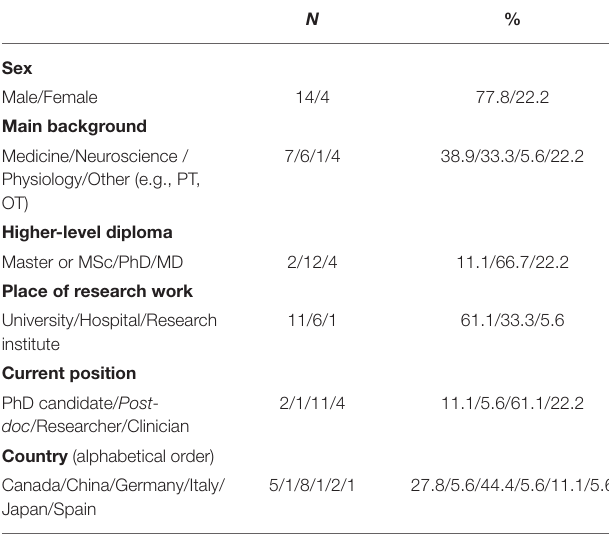
TABLE 1 | Characteristics of the international panel of experts for the two